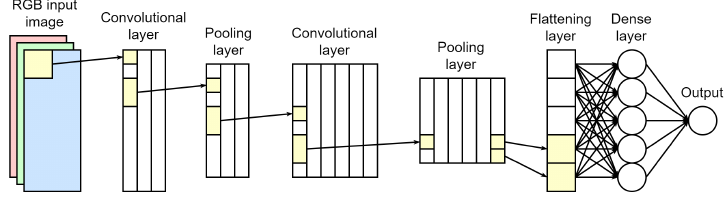
Figure 5. Architecture of the adopted CNN